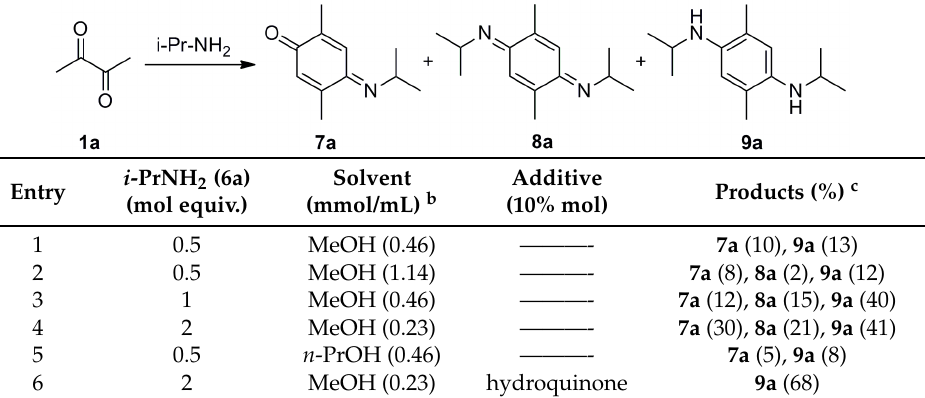
Table 1. Optimization of reaction conditions for the preparation of compounds 7a – 9a a .